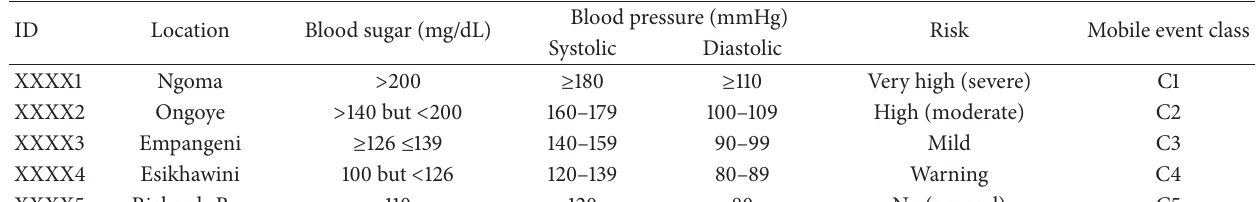
Table 1: The e-health mobile aware records.